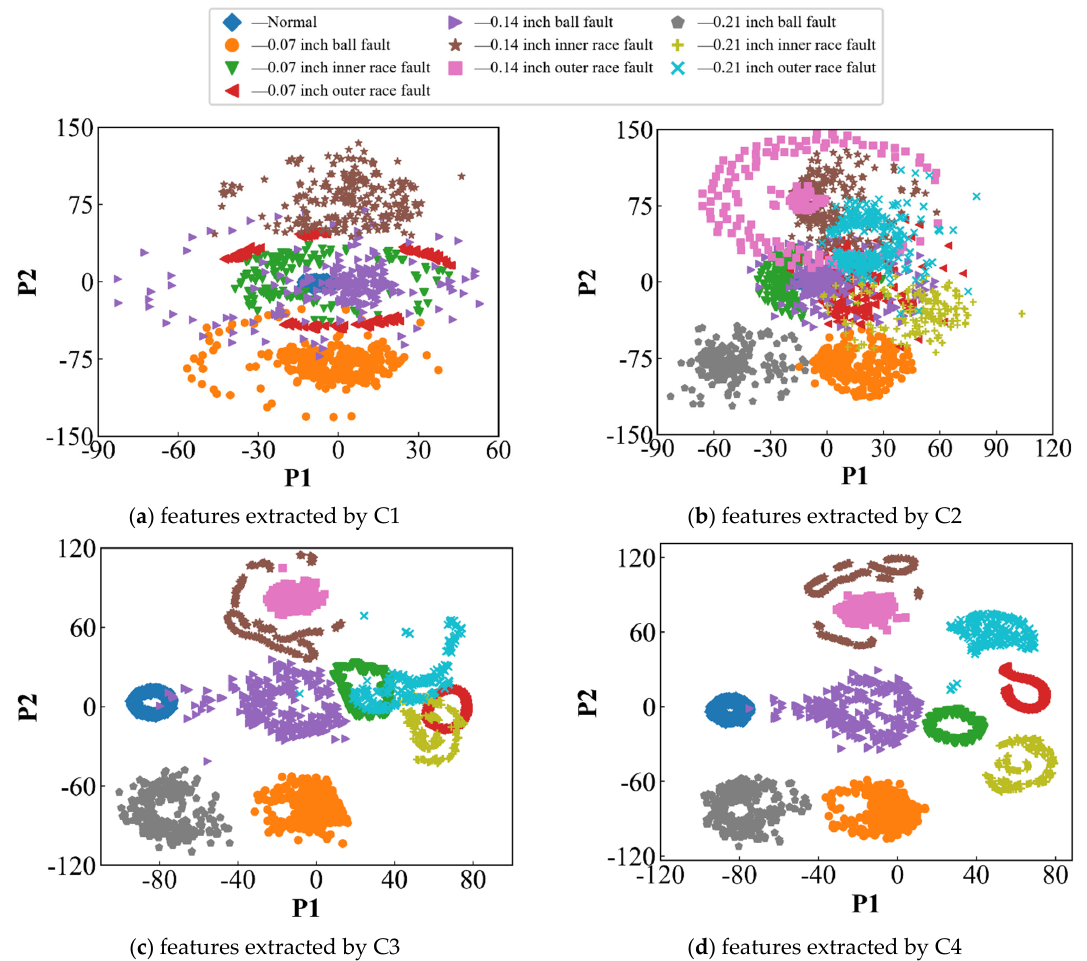
Figure 11. Features scatter diagram based on the proposed model. Table 5. Comparison of loss and accuracy of the two